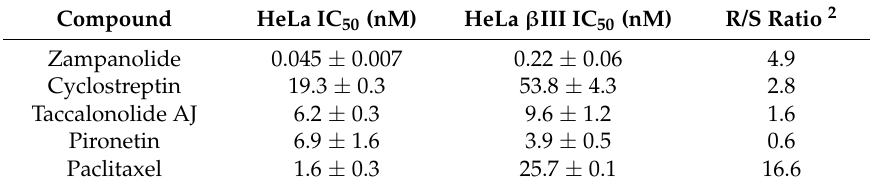
Table 1. IC 50 1 (nM) of covalent compounds in HeLa and in HeLa β III-tubulin overexpressing paclitaxel resistant